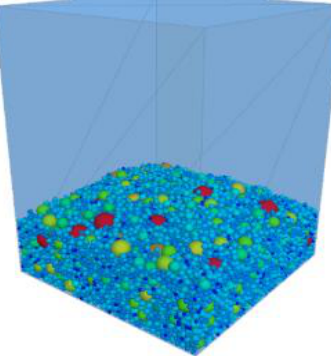
Figure 4. Balance of mixture.